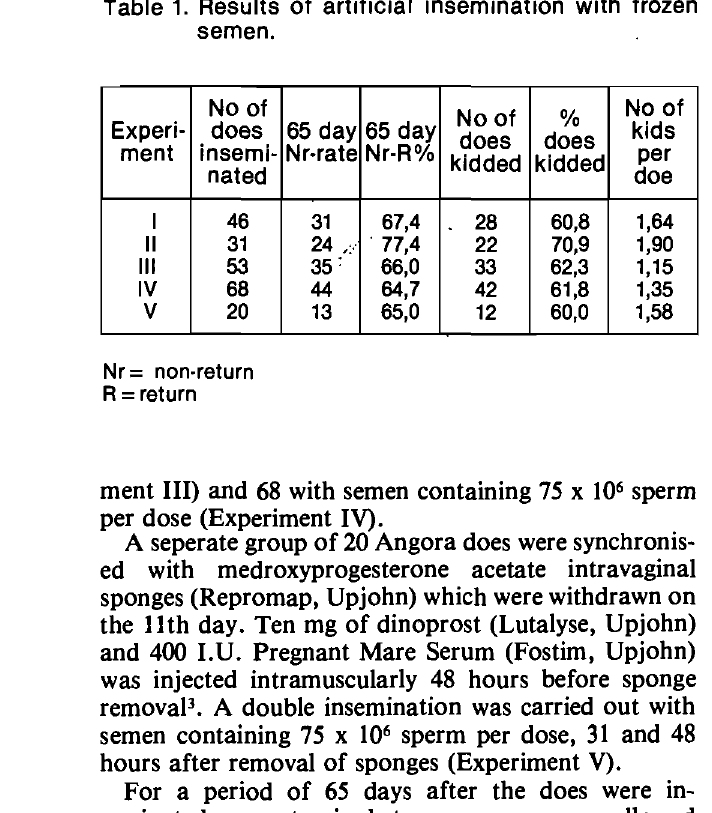
Table 1. Results of artificial insemination with frozen